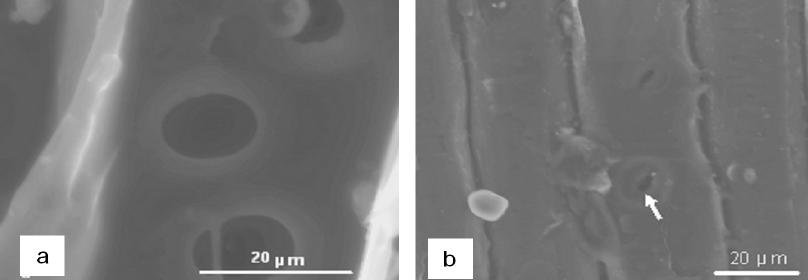
Fig. 3. ESEM micrographs of bordered pits in opposite and compression wood of Picea abies ; a: Bordered pits on radial side of op- posite wood tracheids; b: Bordered pits with slit-like apertures in compression wood